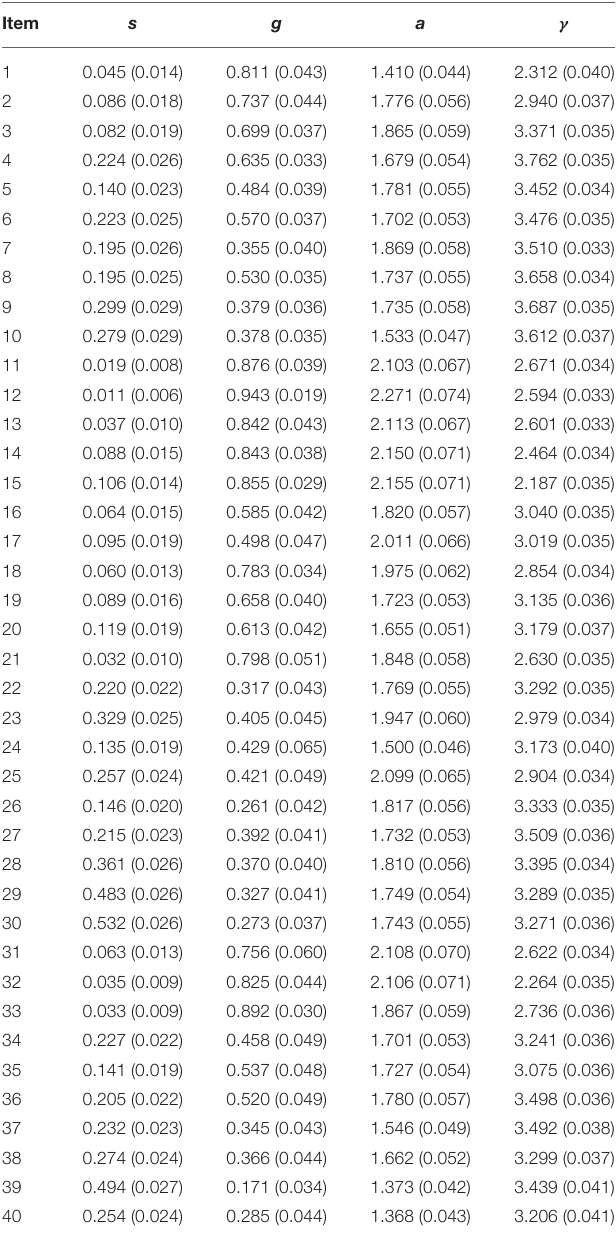
TABLE 4 | The MCMC parameter estimates for item parameters and response time